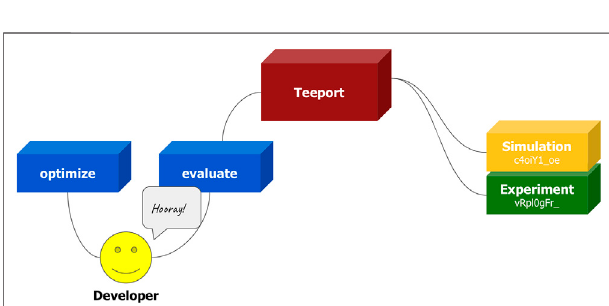
FIGURE 11 | Fast switching between the simulation evaluator and the experimental evaluator. The user can select the evaluator to be optimized upon by the corresponding id, get the speci fi c local evaluator through the use_evaluator (id) API, and perform the